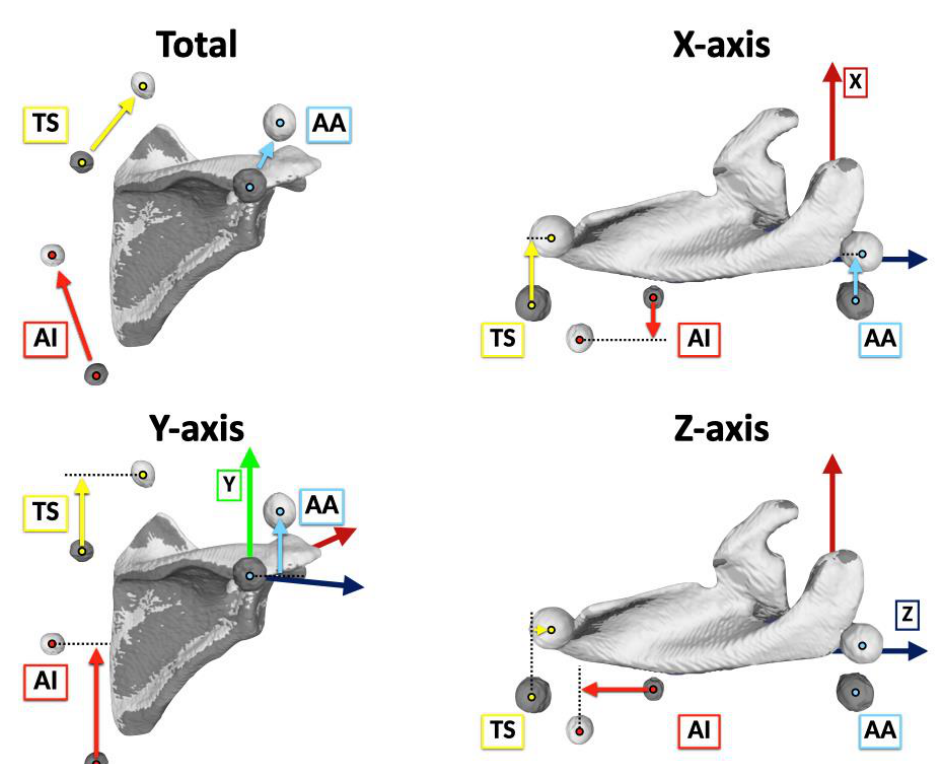
Figure 7. Total and directional marker movements from the reference position (gray) to the elevated position (white). The directional movement was described as anterior/posterior movement of the X- axis translation, superior/inferior movement of the Y-axis translation, and lateral/medial movement of the Z-axis translation. Light blue arrows, yellow arrows, and red arrows indicate the acromial angle (angulus acromialis [AA]), root of the scapular spine (trigonum spinae scapulae [TS]), and inferior angle (angulus inferior [AI]) marker movements, respectively.